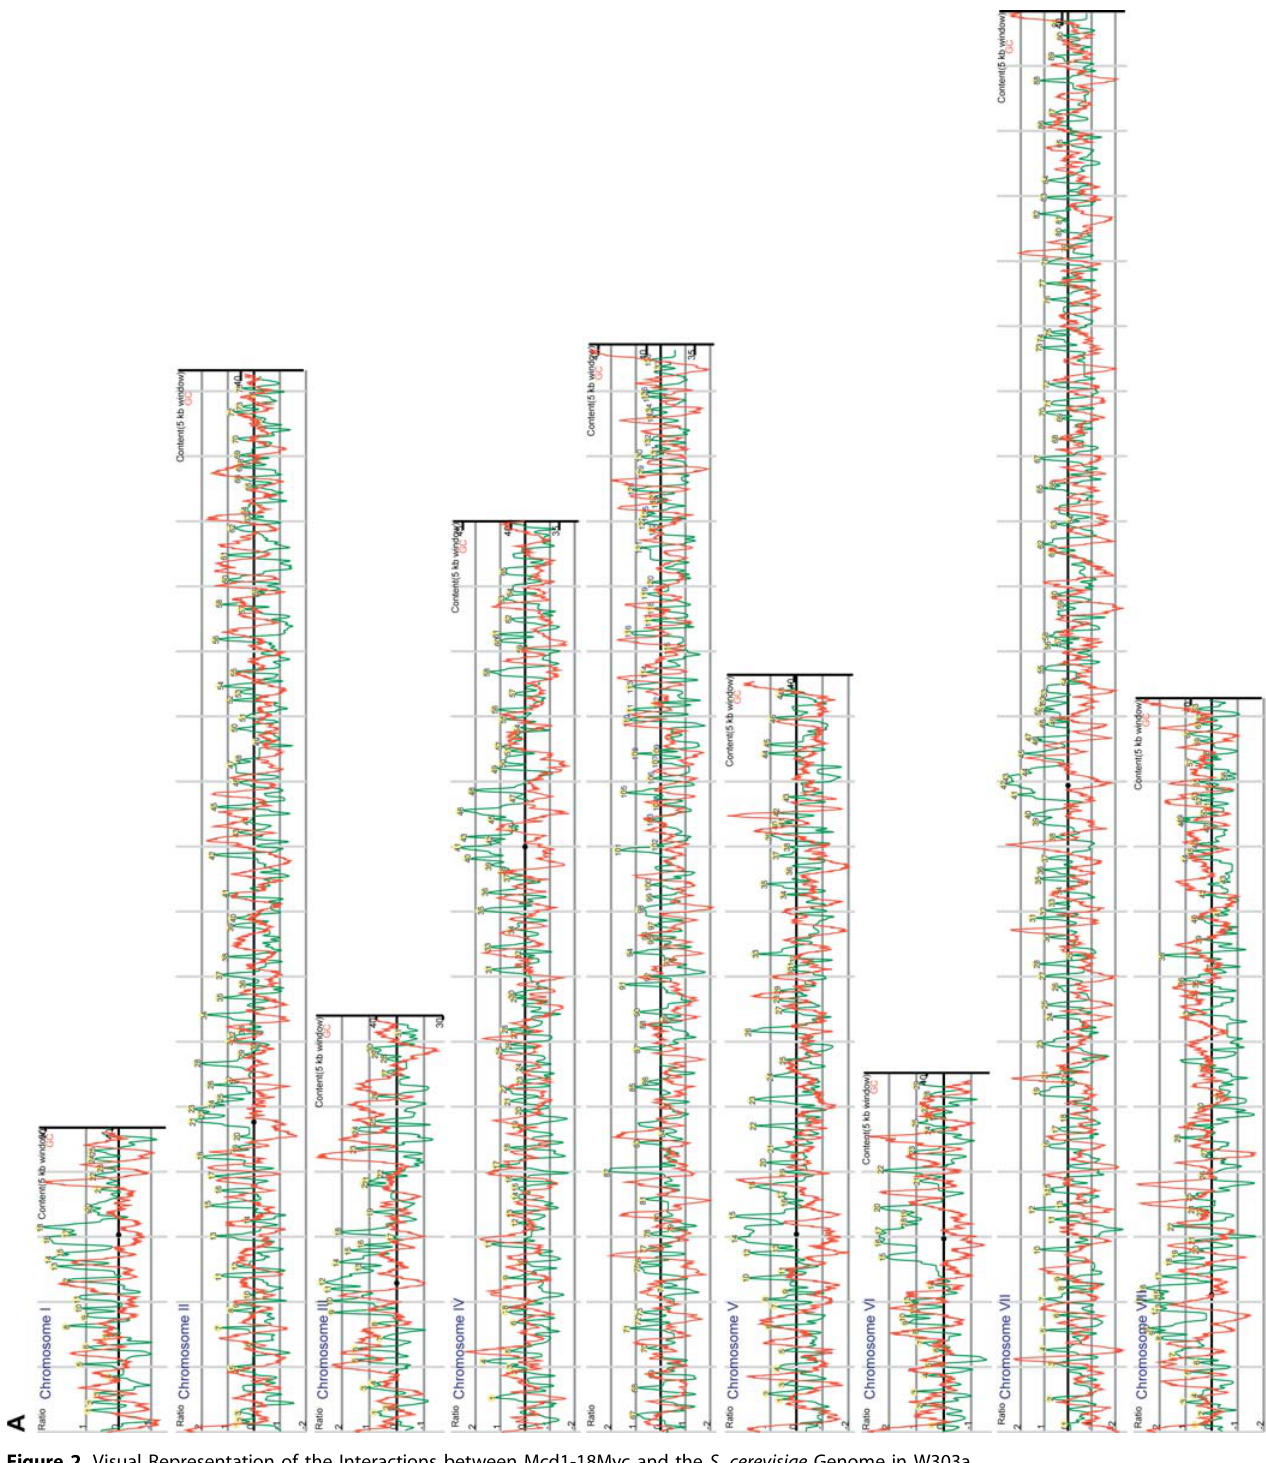
Figure 2. Visual Representation of the Interactions between Mcd1-18Myc and the S. cerevisiae Genome in W303a For each of the 16 chromosomes the centromere is indicated with a black circle, the smoothed data (based on the log 2 of the ratio) is indicated with a green line (left y-axis), and the percent GC is indicated by a red line (right y-axis). Vertical grey bars mark 50-kb intervals. Peaks are located and numbered by PeakFinder (with the exception of telomeres) using the parameters described in the Materials and Methods. For Chromosome XII, peaks 41 and 42 correspond to the previously described peaks CARL1 and CARL2 (Laloraya et al. 2000). DOI: